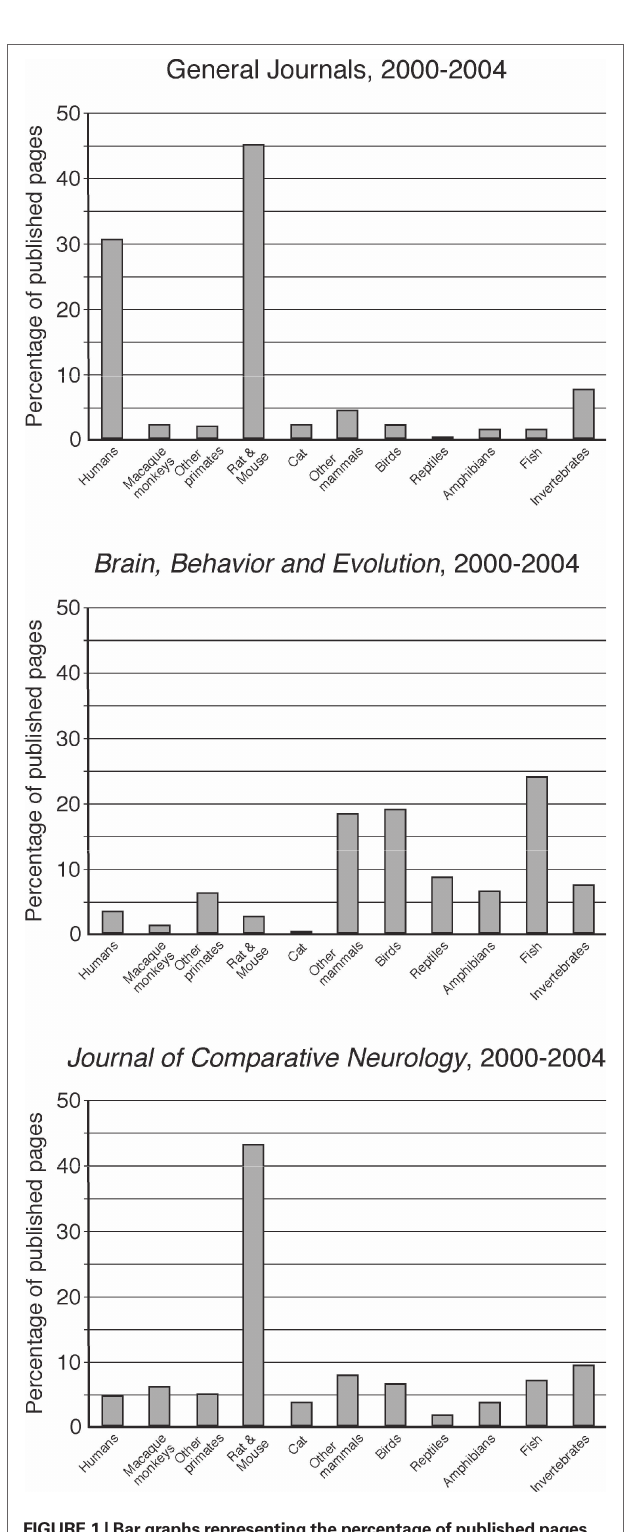
FIGURE 1 | Bar graphs representing the percentage of published pages devoted to each of the phylogenetic groupings classifi ed in the present study for the period 2000–2004 in the general neuroscience group and in each of the two comparative journals. Note the similarity of The Journal of Comparative Neurology to the general neuroscience journals, and the emphasis of the under-represented groups in Brain, Behavior and Evolution